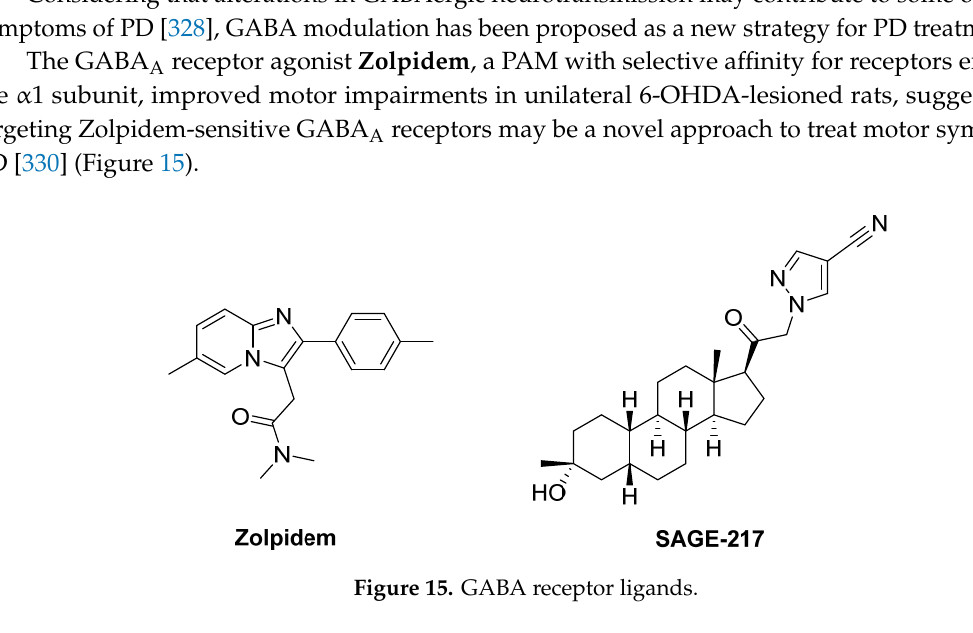
Figure 14. Nicotinic receptor ligands.